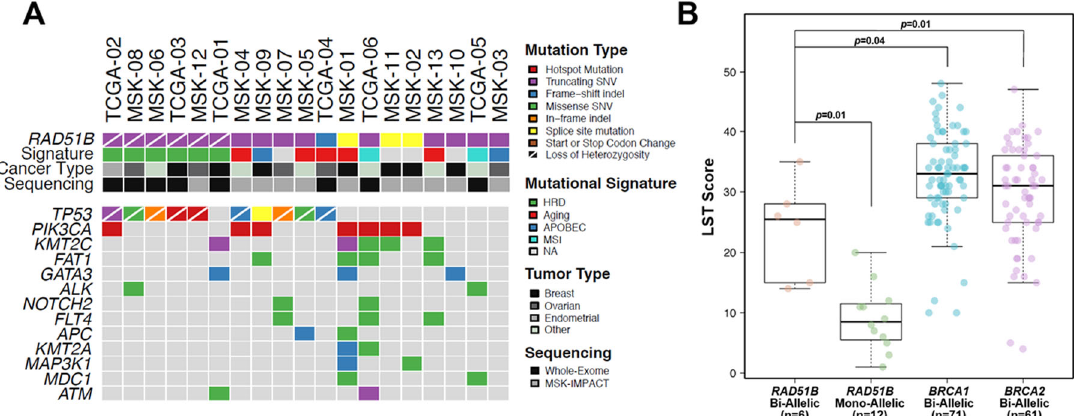
Fig. 1 Genomic landscape of RAD51B -associated cancers. A Recurrent (present in ≥ 2 samples) nonsynonymous somatic mutations identi fi ed in 18 tumors from patients with germline RAD51B mutations using targeted massively parallel sequencing (MSK-IMPACT; n = 8) or whole- exome sequencing (WES; n = 8). Phenobar provides information on RAD51B germline mutations, dominant mutational signatures and cancer type. Loss of heterozygosity (LOH) of the RAD51B wild-type allele is displayed by a white diagonal line. B Large-scale transition (LST) scores in biallelic RAD51B -associated cancers, monoallelic RAD51B -associated cancers, biallelic BRCA1 -associated cancers and biallelic BRCA2 -associated cancers from TCGA.